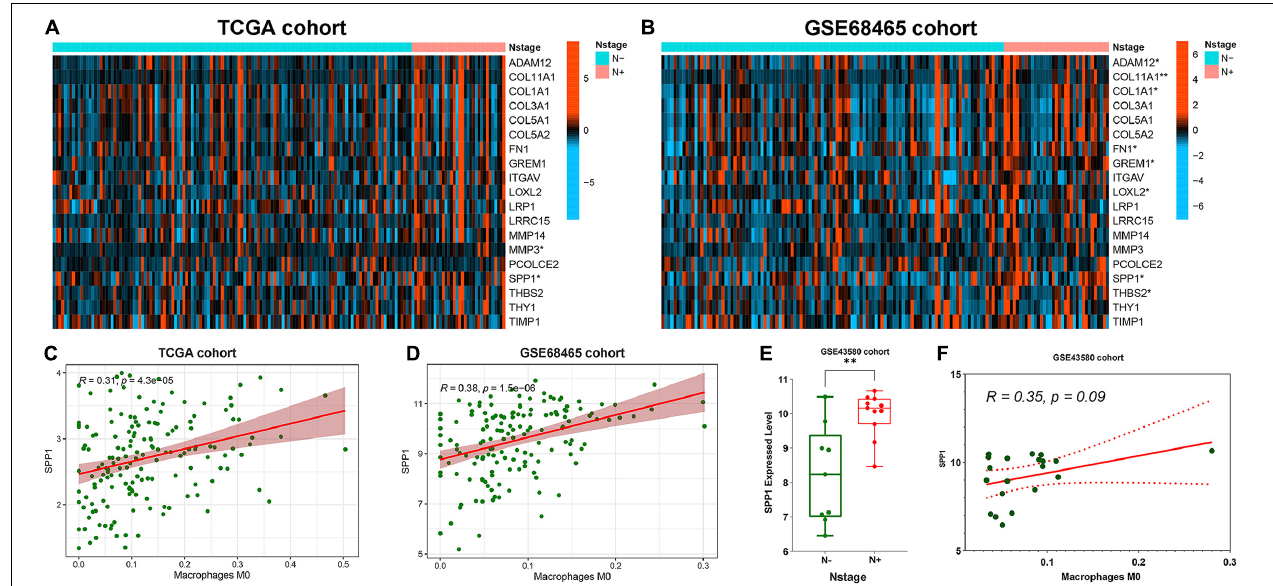
FIGURE 5 | Correlation analysis of secreted phosphoprotein 1 (SPP1) with early lymph node metastasis and macrophage infiltration in Stage-T1 lung adenocarcinoma (LUAD) patients from three external cohorts (TCGA, GSE68465 and GSE43580 cohorts). (A) SPP1 and matrix metalloprotease 3 (MMP3) were associated with N stages in the TCGA cohort. (B) thrombospondin 2 (THBS2), SPP1, lysyl oxidase like 2 (LOXL2), gremlin 1 (GREM1), fibronectin 1 (FN1), collagen type I alpha 1 chain (COL1A1), COL11A1, and ADAM metallopeptidase domain 12 (ADAM12) were associated with N stages in the GSE68465 cohort. TCGA cohort (C) and GSE68465 cohort (D) analysis verified that SPP1 was significantly positively correlated with M0 infiltration. In the GSE43580 cohort, SPP1 was highly expressed in the lymph node metastasis group (E) , and the correlation between SPP1 and M0 was also investigated (F) . * p < 0.05, ** p <